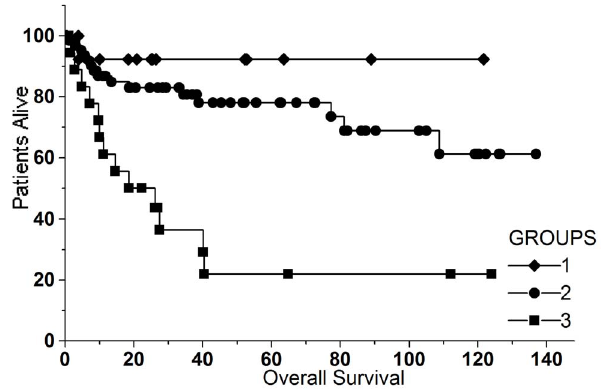
Figure 5. overall survival of the patients according to the number of CD34 + /CD13 + cells separated in three groups with a different survival by cluster analysis. Group 1 median: 0.07 (0.02– 0.11), group 2 median: 0.46 (0.14–2.36) and group 3: median 5.07 (2.90– 27.9) (p , 0.0001).